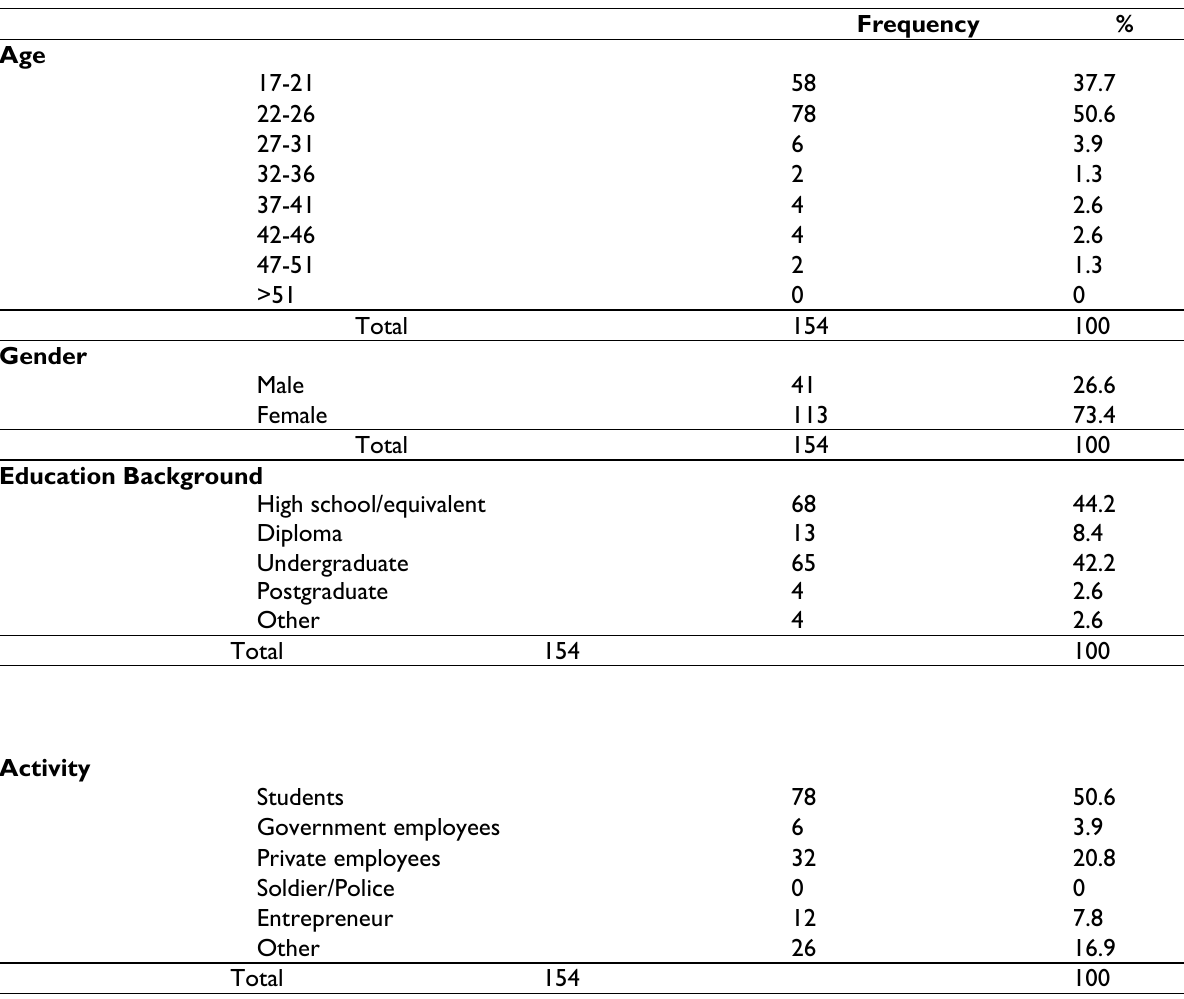
Table 2. Respondent